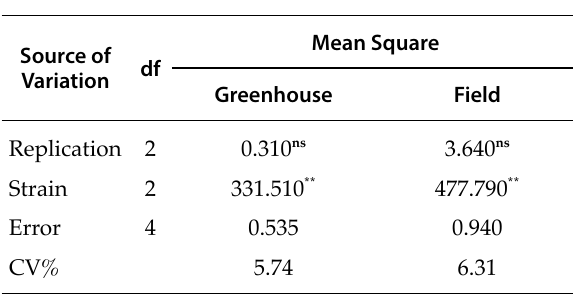
Table 1. Analysis of variance on the basis of randomized complete block design for lesion length measured in path - ogenicity tests of Diplodia bulgarica on apple in greenhouse and field conditions.